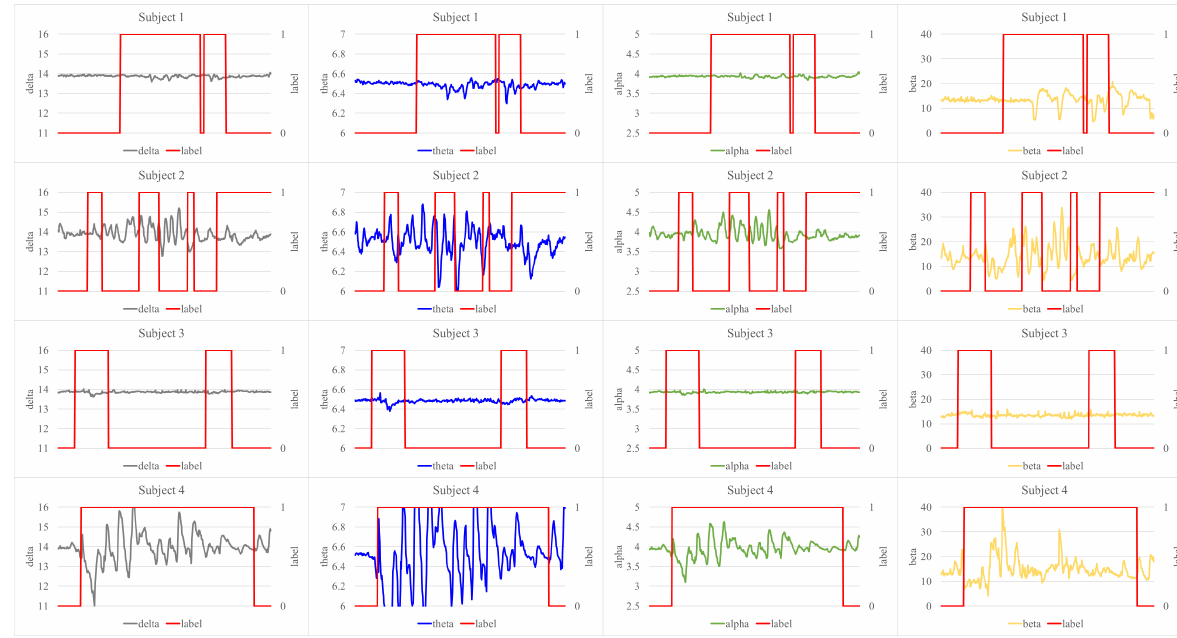
Figure 13. Graphs between the amplitudes of EEG-signal’s four frequency bands and the inattention labels obtaining from each subject during flight. Each row represents the subject, and each column represents the frequency band of the